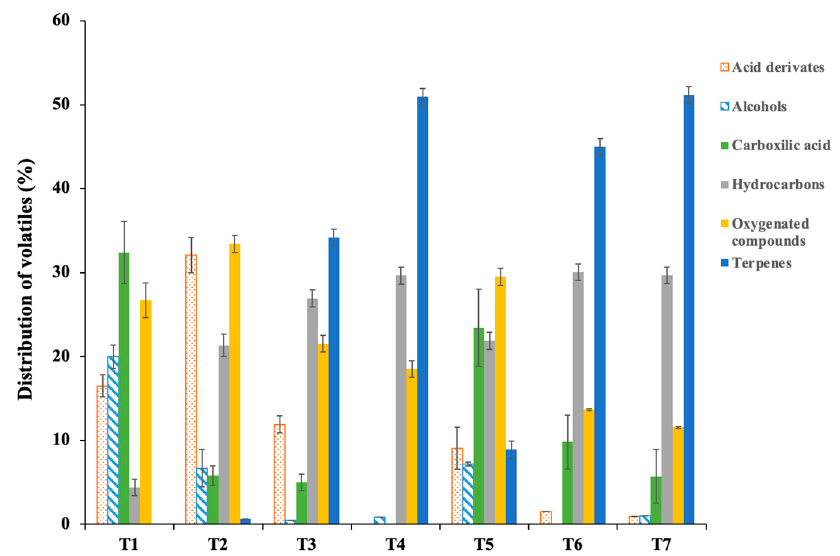
Figure 2. The distribution of the percentage of VOCs in the different treatments. T1: olives with ferrous gluconate stuffed with 0% of ‘Mojo picón’; T2: olives with fresh Carao stuffed with 0% of ‘Mojo picón’; T3: olives with lyophilized Carao stuffed with 0% of ‘Mojo picón’; T4: olives with fresh Carao stuffed with 2% ‘Mojo picón’; T5: olives with fresh Carao stuffed with 4% of ‘Mojo picón’; T6: olives with lyophilized Carao stuffed with 2% of ‘Mojo picón’; T7: olives with lyophilized Carao stuffed with 4% of ‘Mojo picón’.